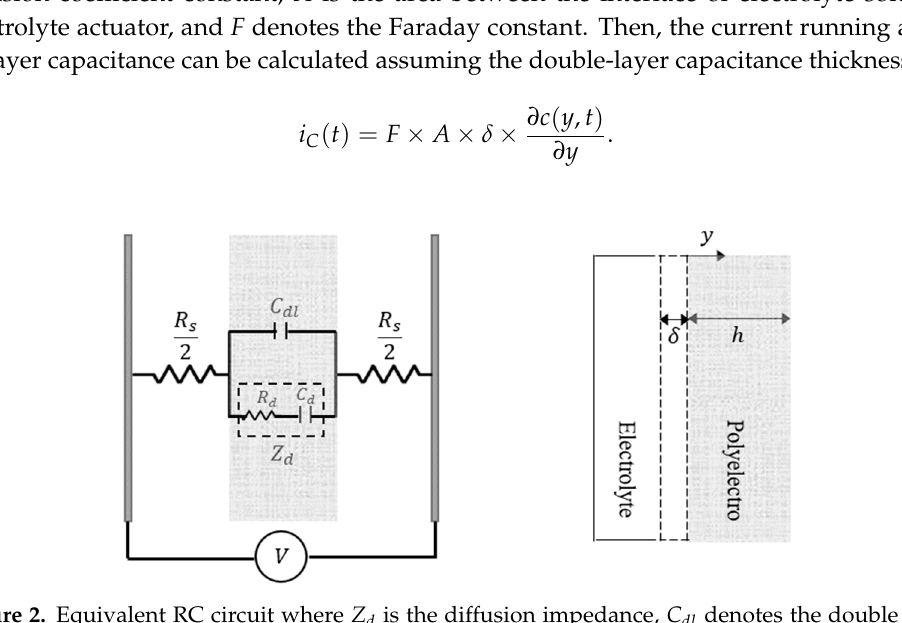
Figure 2. Equivalent RC circuit where Z d is the diffusion impedance, C dl denotes the double layer capacitance, and R s refers to the resistance of the electrolyte solution.